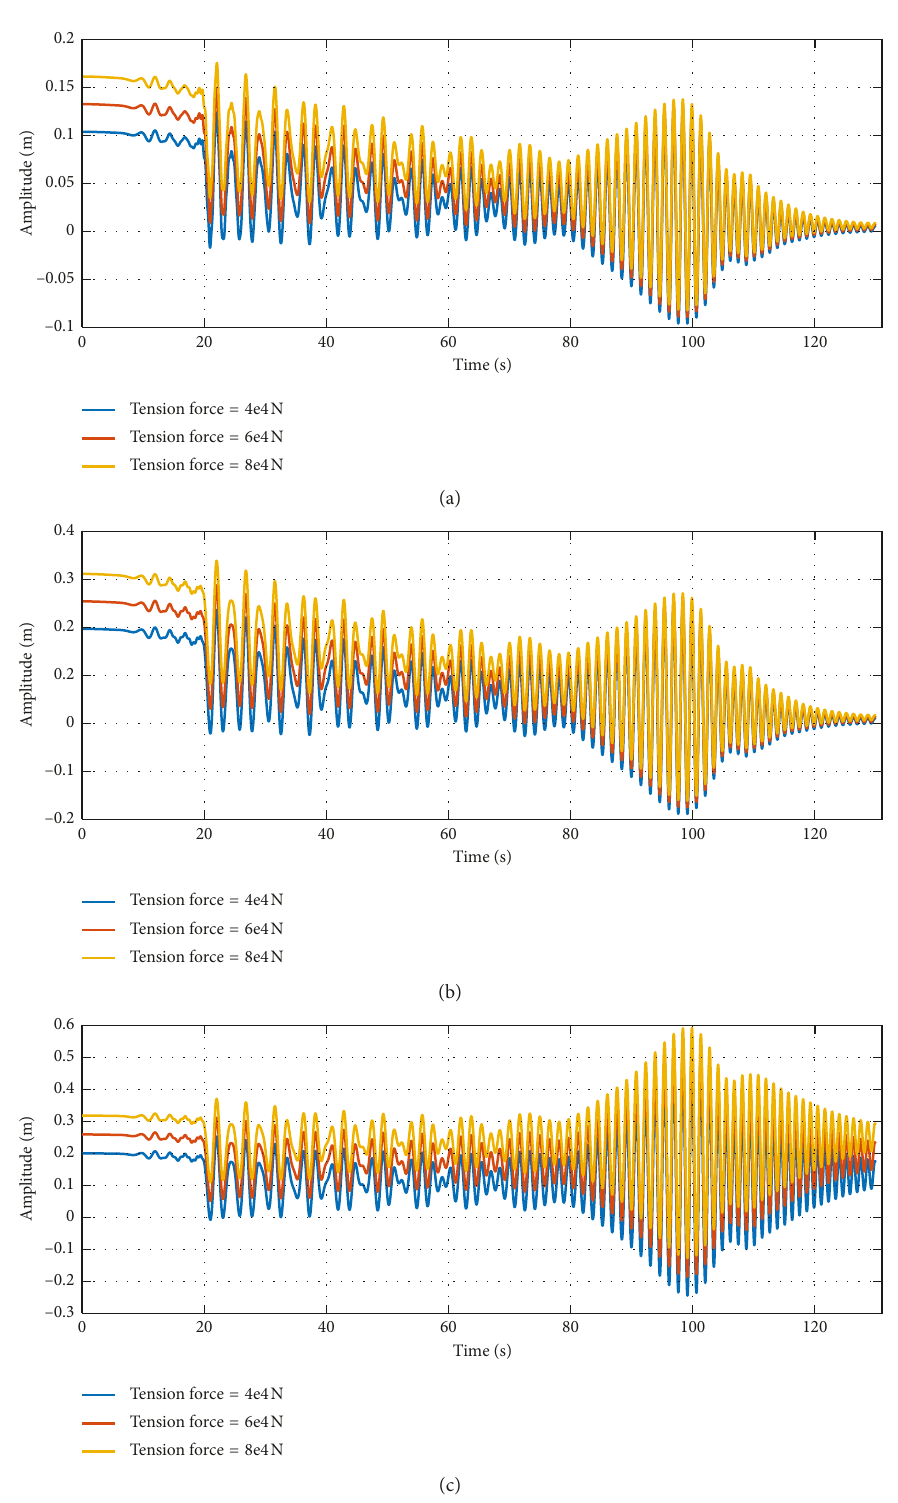
Figure 20: Longitudinal responses of the tensioned traction system at the (a) midpoint of the lifting rope, (b) conveyance, and (c) end point of the compensating